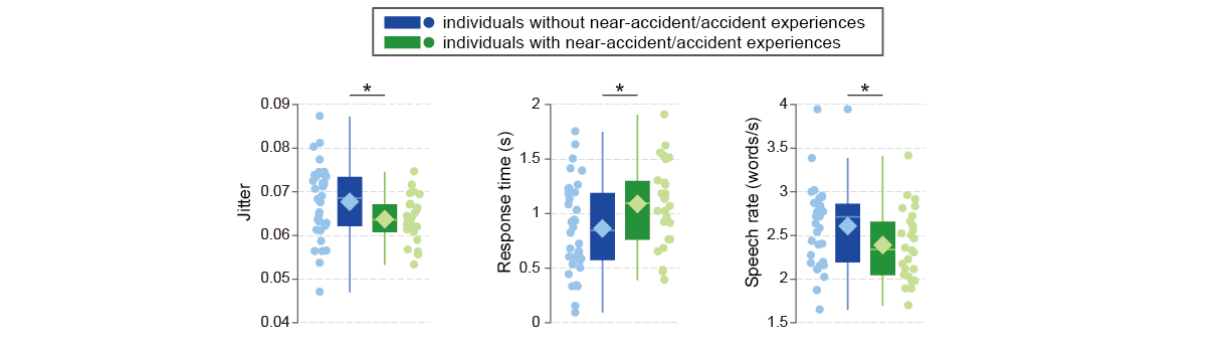
Figure 2. Box plots (line and diamond represent median and mean, respectively) for speech features with significant differences between individuals with and without accident or near-accident experiences—jitter: P =.034; response time: P =.040; speech rate: P =.048.